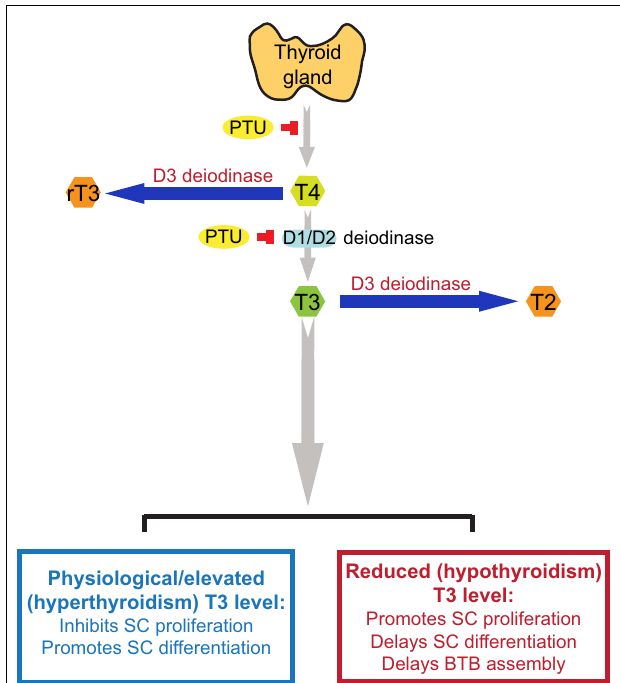
FIGURE 1 |A schematic drawing to illustrate the physiological role of thyroid hormoneT3 on testis function .This schematic drawing was prepared based on findings in the literature as discussed herein (see text for details). In short,T4 is the principal thyroid hormone produced by the thyroid gland and released into the systemic circulation.T4, however, is a pro-hormone, which is being activated via the action of deiodinases D1 or D2, mostly in the liver and kidney but also the testis, to formT3, the activated thyroid hormone. However, D1, D2, and D3 deiodinases are also found in the testis.The use of goitrogen [e.g., propylthiouracil (PTU)] can block the production ofT4 by thyroid gland, which was used to examine the effects of thyroid hormones on testicular function. D3 deiodinase, unlike D1 and D2 deiodinases that activatesT4 toT3, de-activatesT4 orT3 to rT3 orT2, respectively, which are inactivated thyroid hormones, providing a crucial mechanism to regulate intracellular thyroid hormone action in cells, such as in Sertoli and/or germ cells in the testis. It is known that high level ofT3 inhibits Sertoli cell proliferation and promotes Sertoli cell differentiation, whereas low level ofT3 causes delayed Sertoli cell proliferation and differentiation. It is noted that at puberty ( ∼ 12 years of age) in men or by day ∼ 15-17 day in rodents, there is a surge inT3 level in systemic circulation, coinciding with Sertoli cell differentiation when Sertoli cells cease to divide (see text for details). T4, 3,5,3 (cid:48) ,5 (cid:48) -tetraiodothyronine;T3, 3,5,3 (cid:48) -tri-iodothyronine; rT3, 3,3 (cid:48)